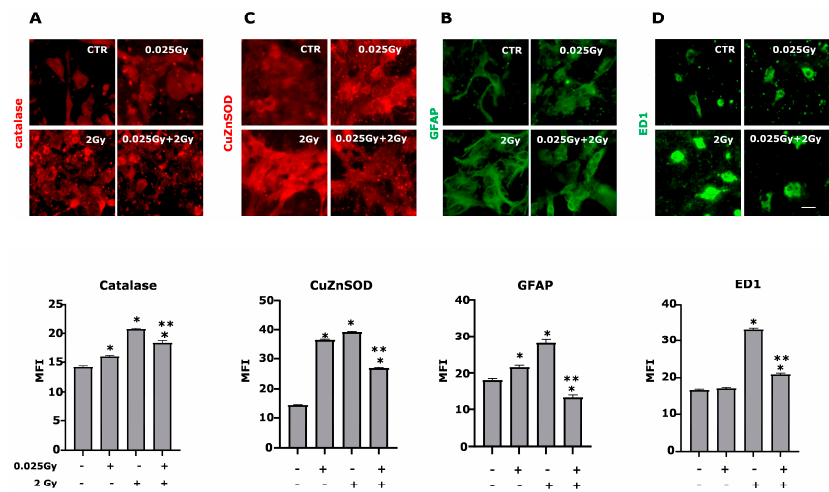
Figure 5. The priming dose reduces antioxidant enzymes and glial markers level. The expression of antioxidant enzymes (catalase and CuZnSOD) and cell type markers (GFAP for astrocytes and ED1 for microglia) were evaluated in retinal cell cultures irradiated or not by 2 Gy and/or 0.025 Gy 24 h after the last delivered dose by immuno-fluorescence techniques. Representative photomicrographs of catalase (panel ( A ); red), CuZnSOD (panel ( C ); red), GFAP (panel ( B ), green) and ED1 (panel ( D ), green) are shown. Mean fluorescence intensities (MFI value) are shown beside respective panels. (data are the means ± SEM of 700–1500 cells for each condition). ( p < 0.0001 one-way ANOVA, * p < 0.001 vs. CTR; ** p < 0.001 vs. 2 Gy, unpaired two-tailed Student’s t -test). Scale bar 30 µ m.